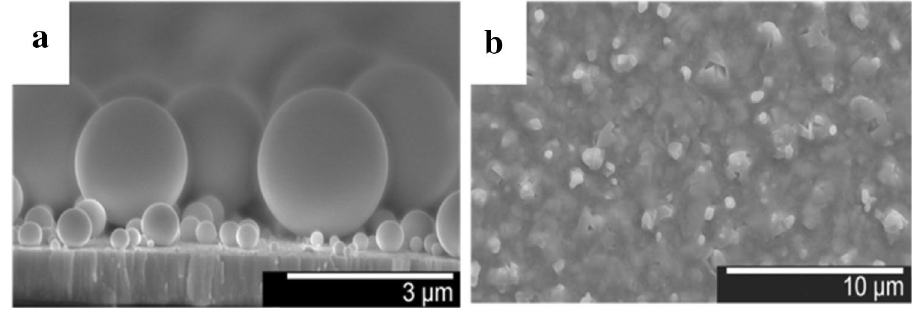
images of metallic Ga droplets electrodeposited on Mo from Reline–GaCl 3 50 mM at 1.1 V/ Ag for 30 min at 60 °C, b SEM top-view of a Ga deposit on Mo/ Cu from Reline–GaCl 3 50 mM at 0.9 V for 15 min at 60 °C. Adapted from Steichen et